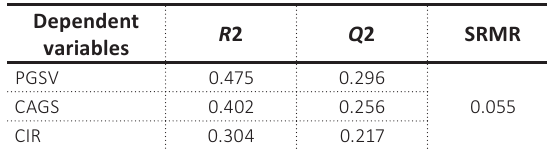
Table 4. R2, Q2, SRMR